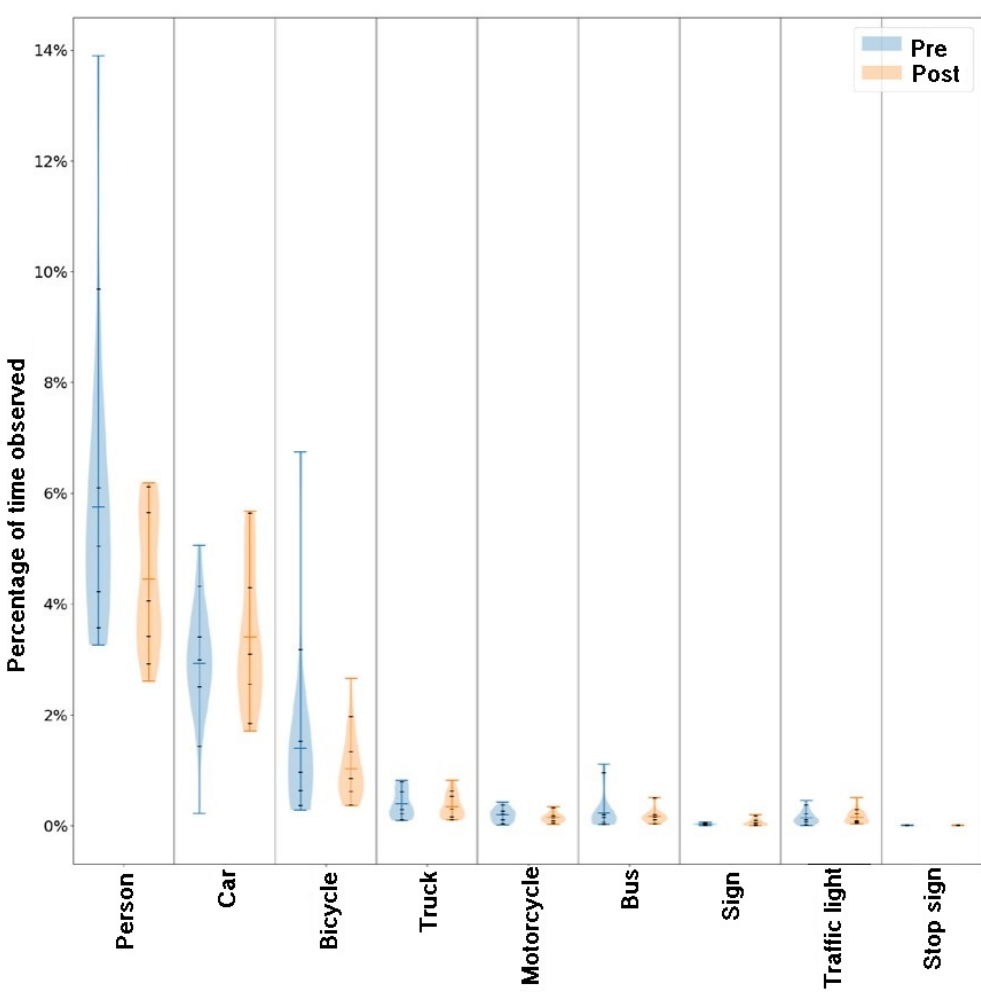
Figure 6 Time spent looking at different road users or signs, aggregated across participants (the median is represented by a longer line within the